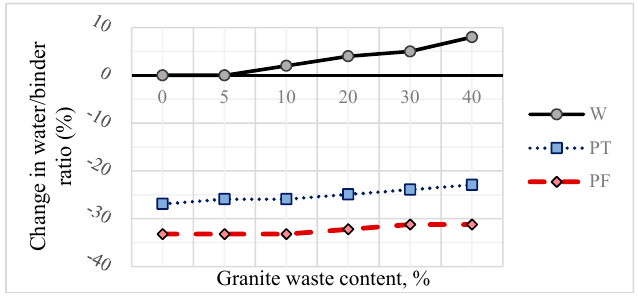
Figure 7. W/c versus percentage of cement replacement by WGP .